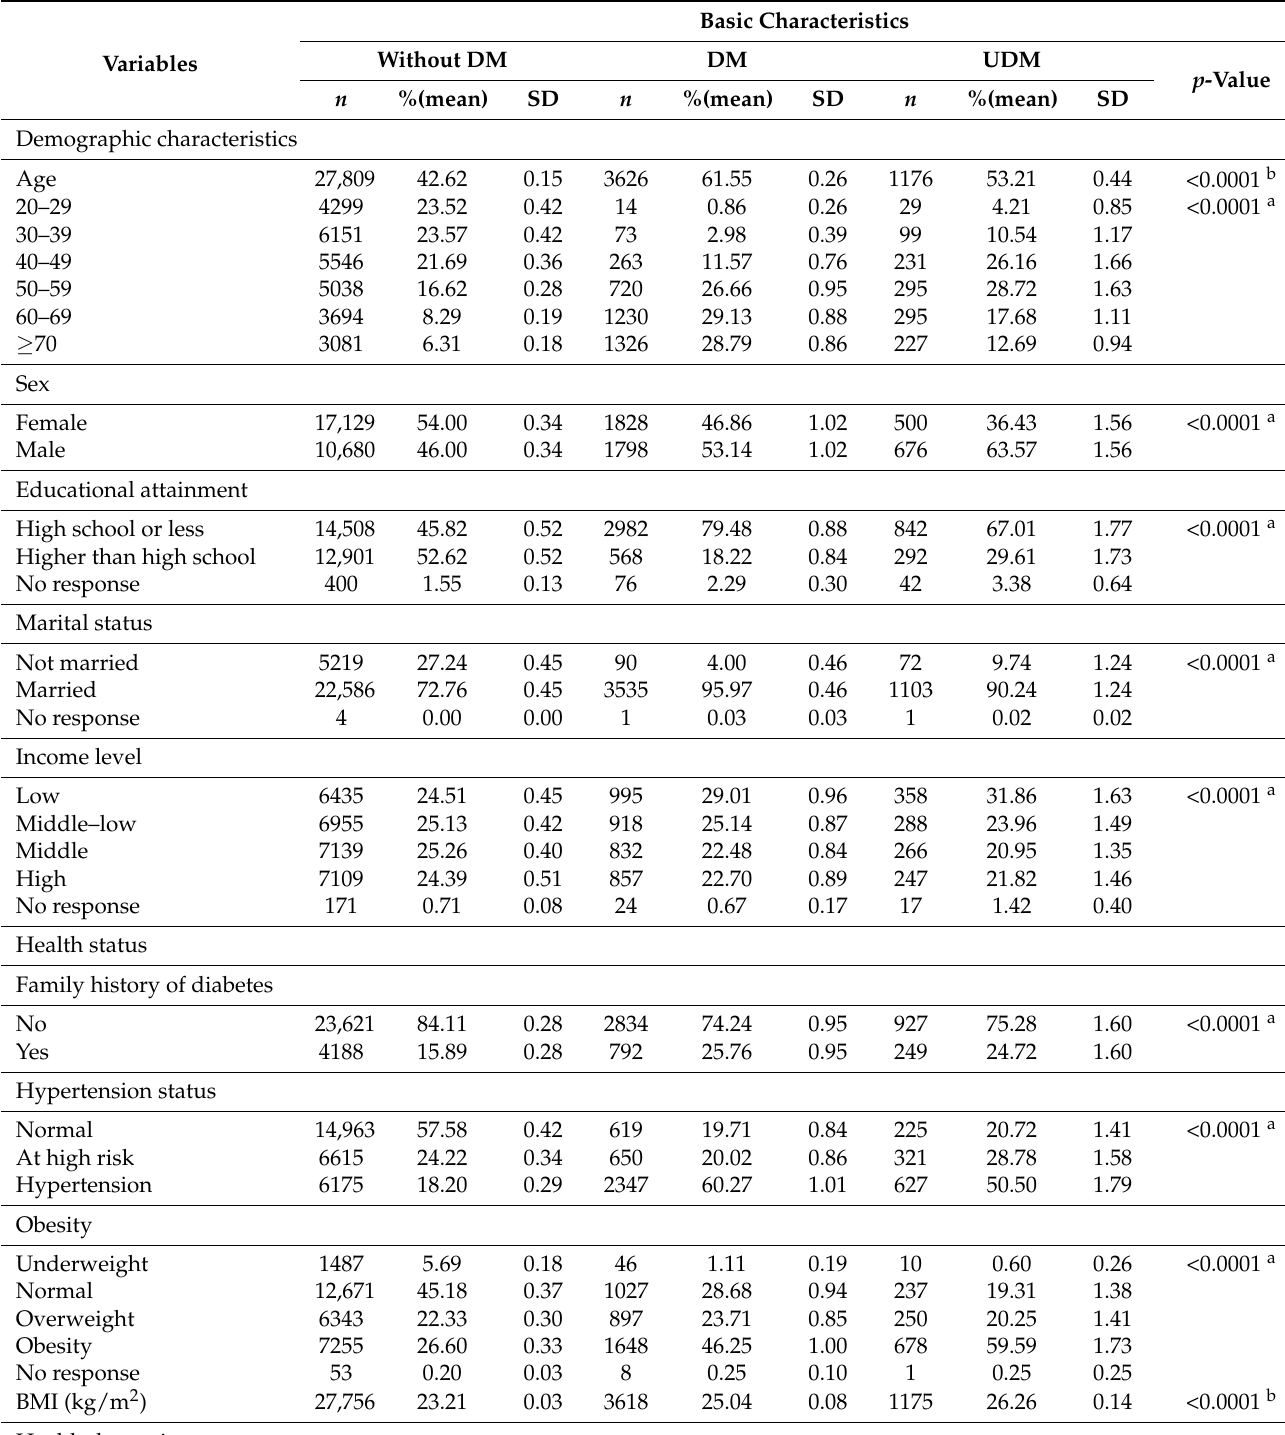
Table 1. Basic characteristics of the without-DM, with-DM, and UDM